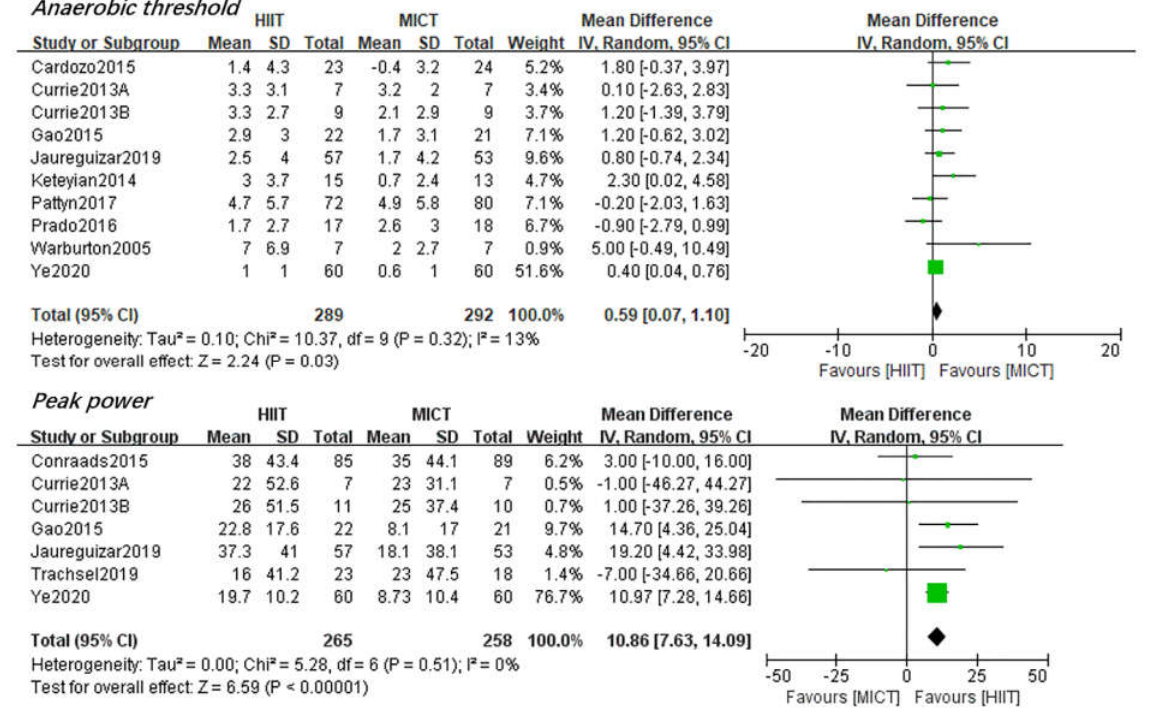
Figure 5. Changes in AT and Peak Power between HIIT and MICT. The green and black symbol means the mean difference of each studies and total mean difference.